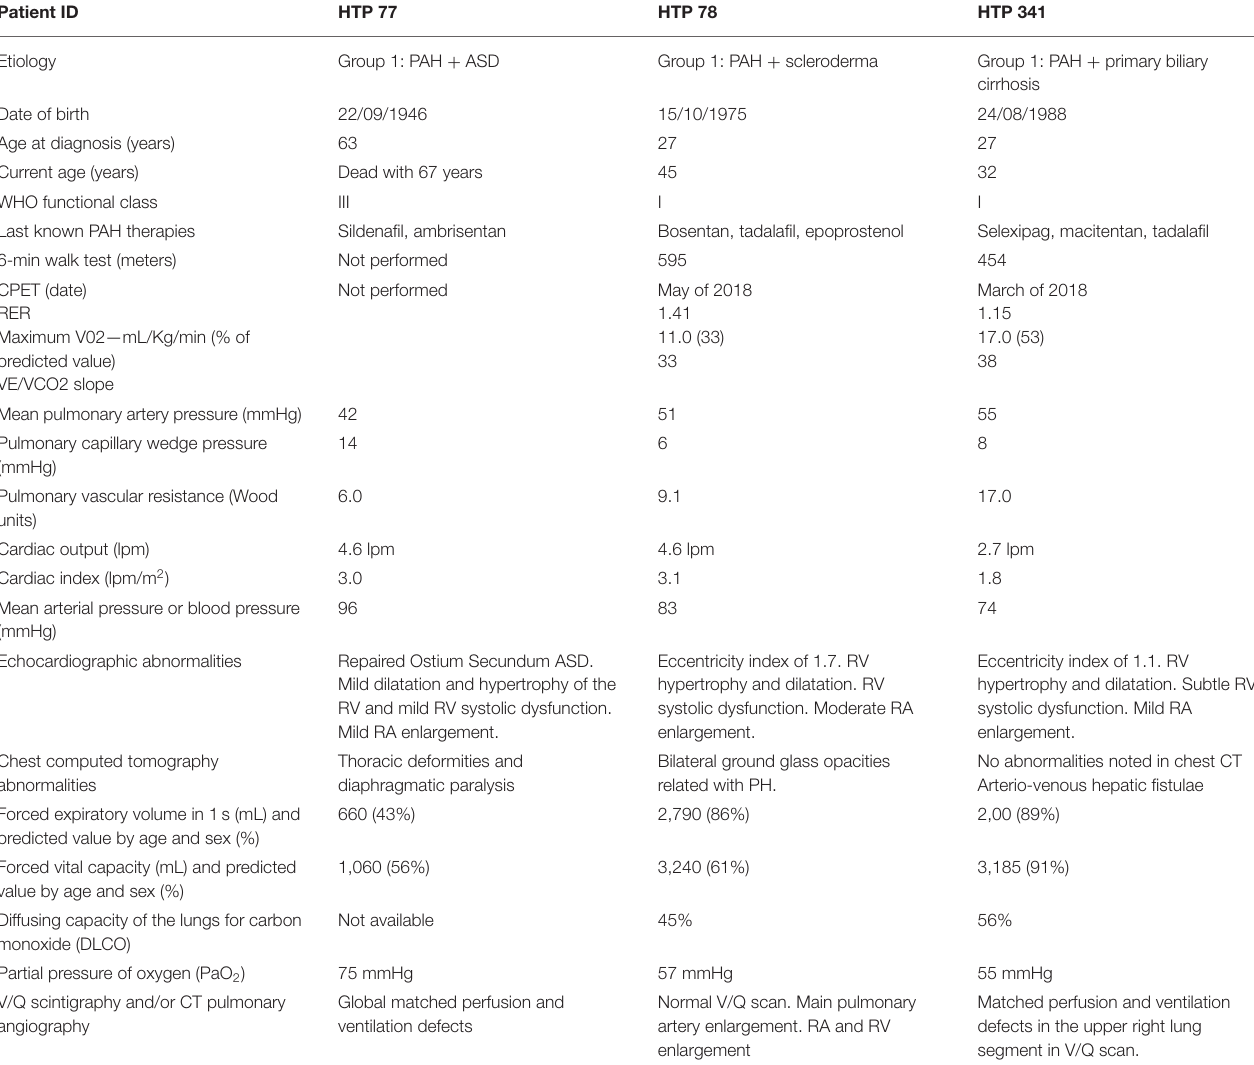
TABLE 1 | Clinical features of patients.